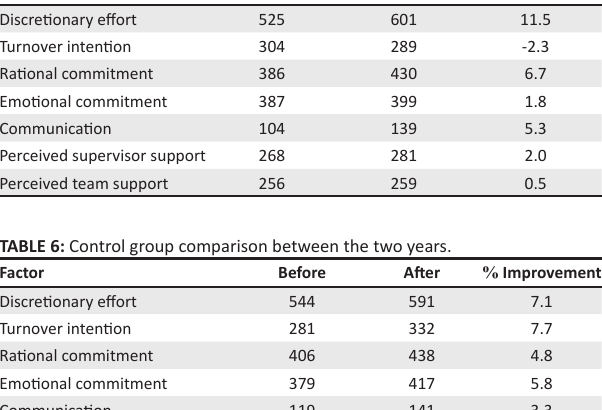
TABLE 5: Experimental group comparison between the two years.